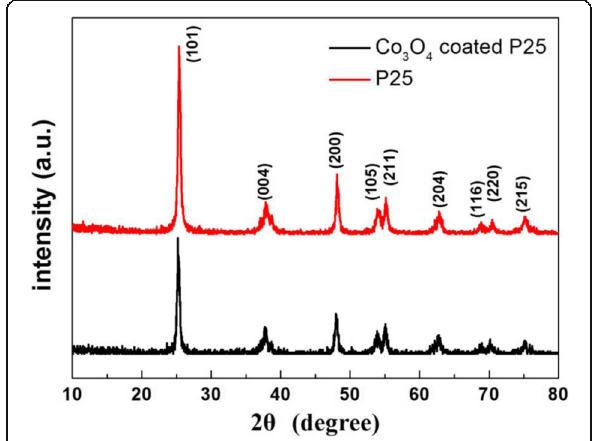
Fig. 1 XRD patterns of pure P25 and 200-cycle Co 3 O 4 -coated P25